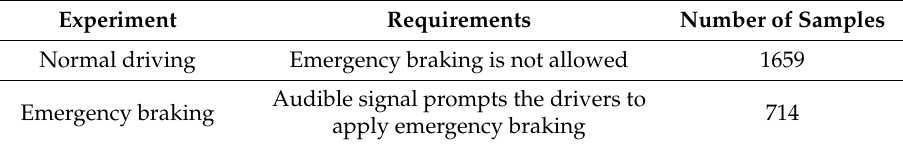
Table 3. Details of the two series of